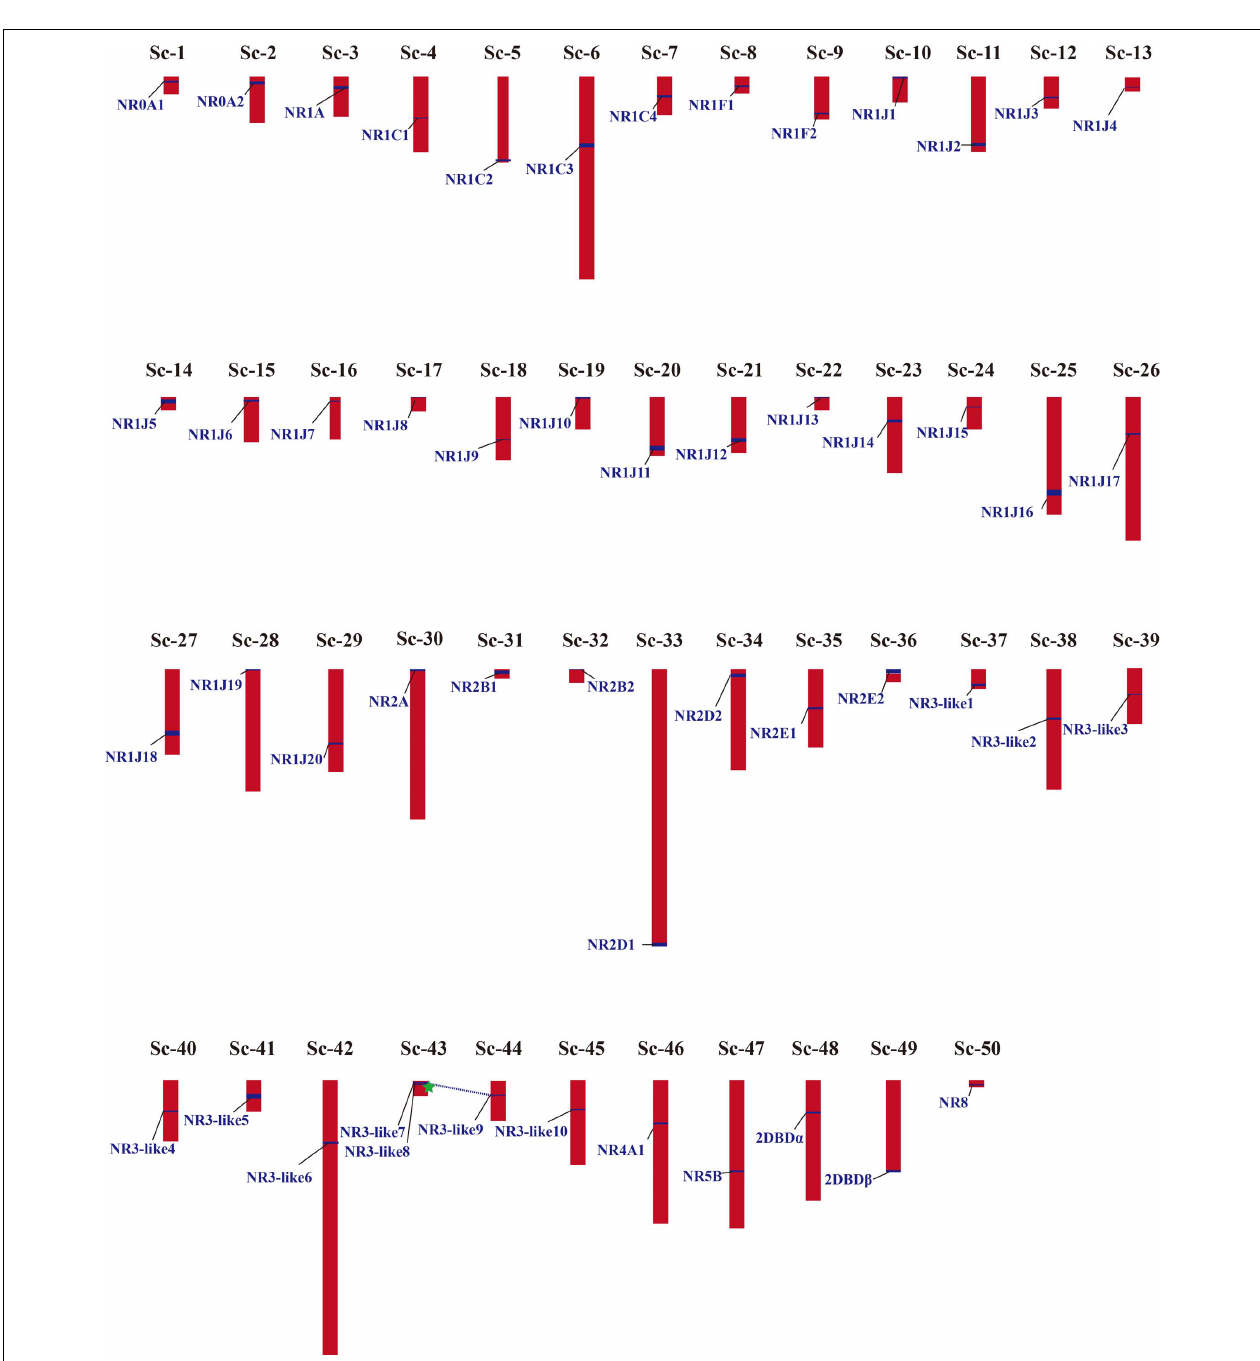
FIGURE 3 | Chromosomal locations and gene duplication events of NR genes in M. lignano . Their detailed scaffold IDs are recorded in Supplementary Table 5 . The NR genes from SD are linked by blue dashed lines, and from TD are marked by green star. The detailed map of the TD and SD is provided in Supplementary Figure S3